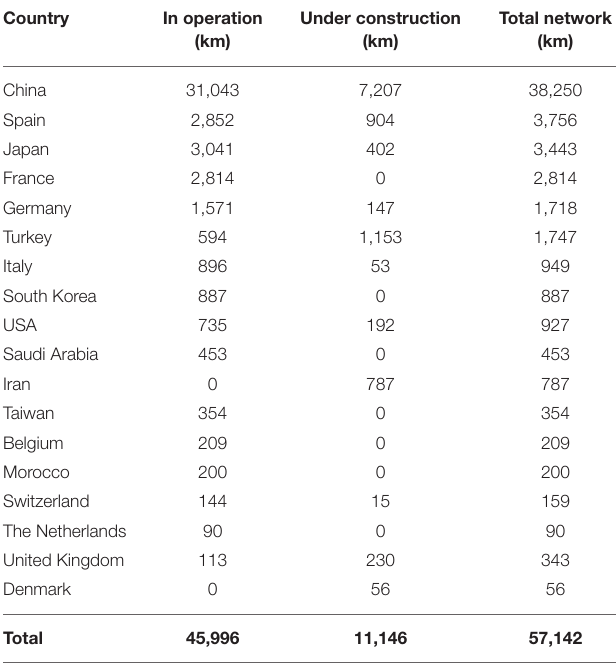
TABLE 1 | Overview of HSR network by country in 2019. Country In operation